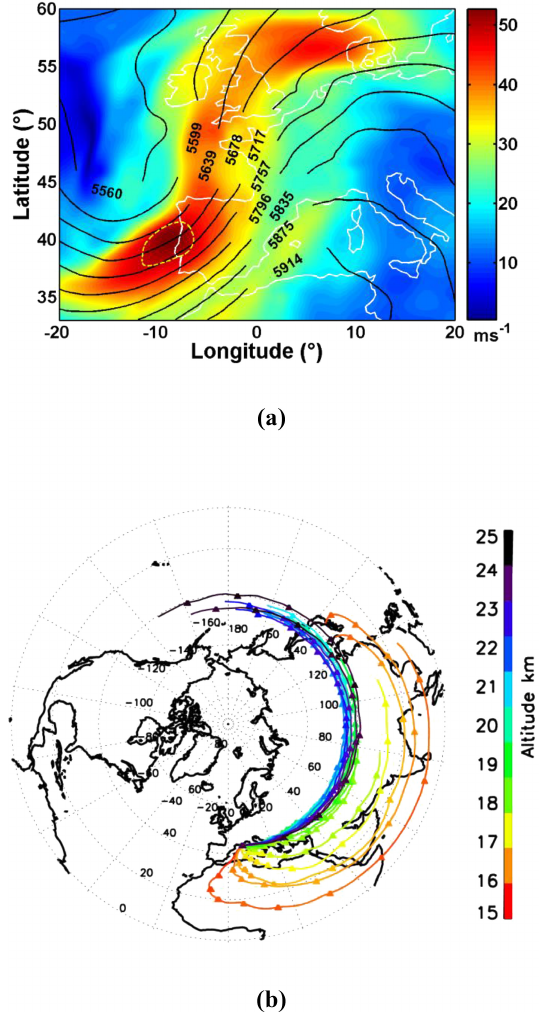
Figure 2. (a) Latitude–longitude distribution of wind speed (ms − 1 ) at 300hPa on 27 July at 12:00UTC (colour scale: red relatively high values, blue relatively low values). Wind speed exceeds > 50ms − 1 above west of Portugal (yellow dashed line), solid lines indicate geopotential height (m) at 500hPa derived from ECMWF opera- tional analyses on 27 July at 12:00UTC, (b) Backward air mass tra- jectories using the FLEXTRA model starting at every 1km height from levels of 15–25km above Ile du Levant during 10 days from 27 July at 23:00UTC, interval between two triangles corresponds to a duration of 24h. Colour indicates altitude